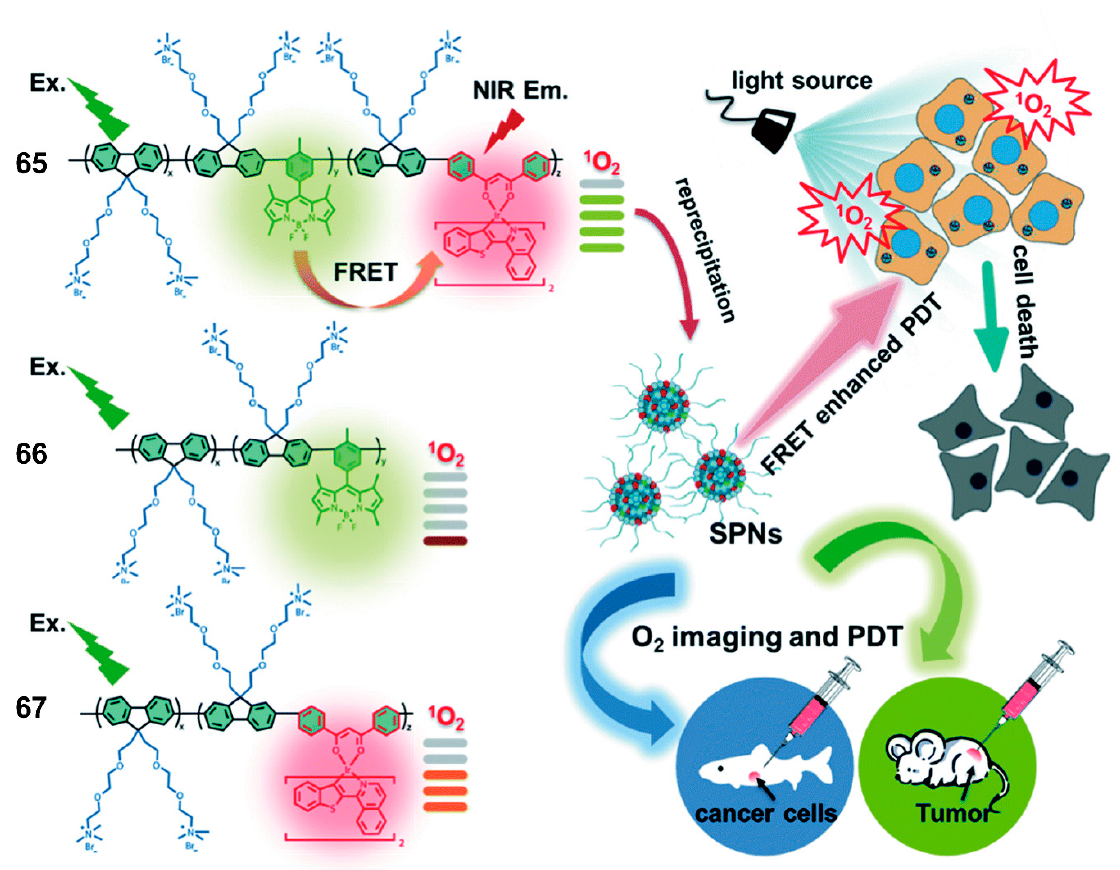
Figure 22. Chemical structures of polymers 65 – 67 and graphical representation of 65 used as photosensitizers with enhanced 1 O 2 generation through Förster resonant energy transfer (FRET) for efficient tumor treatment (Reproduced with permission from Reference [94]. Copyright @ 2019 Royal Society of Chemistry).